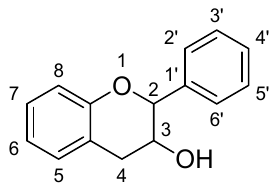
Figure 41. Skeleton of Flavanols.